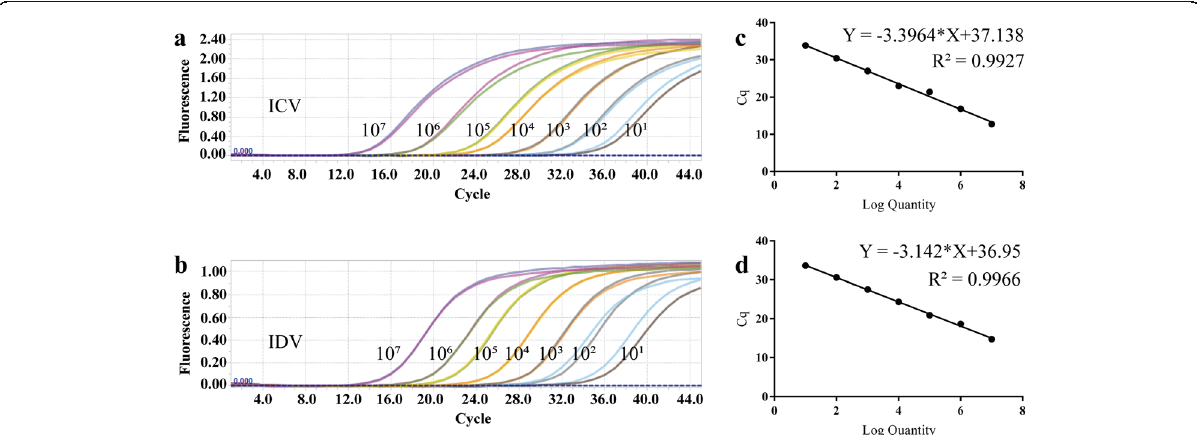
Fig. 1 Preparation of plasmid standards. a , b Amplification curves of ICV and IDV for each plasmid standard at concentrations ranging from 1 × 10 7 copies/ μ L to 1 × 10 1 copies/ μ L; c , d standard curves of plasmid standards of ICV and IDV. All standard curves were generated using GraphPad Prism 6